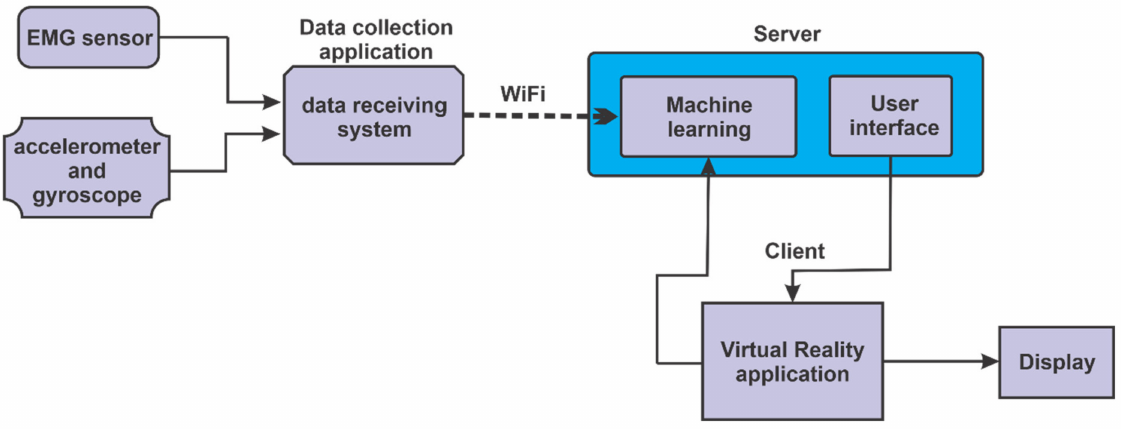
Figure 1. Interconnection of